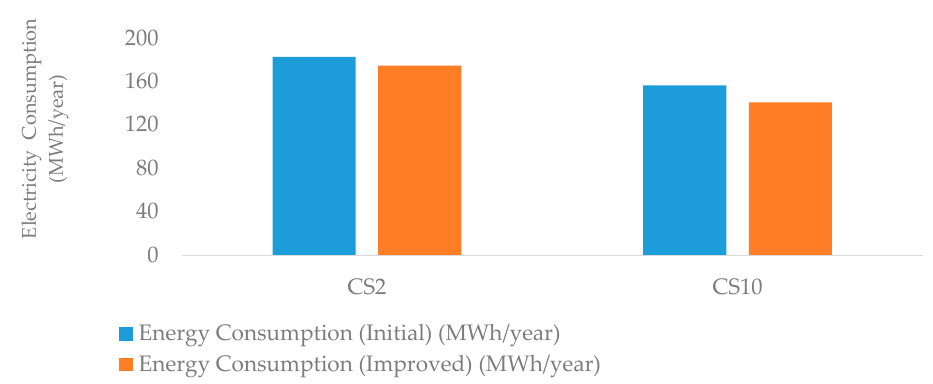
Figure 7. Electricity consumption for the initial and improved operation of the IWC (Low consumption cases).